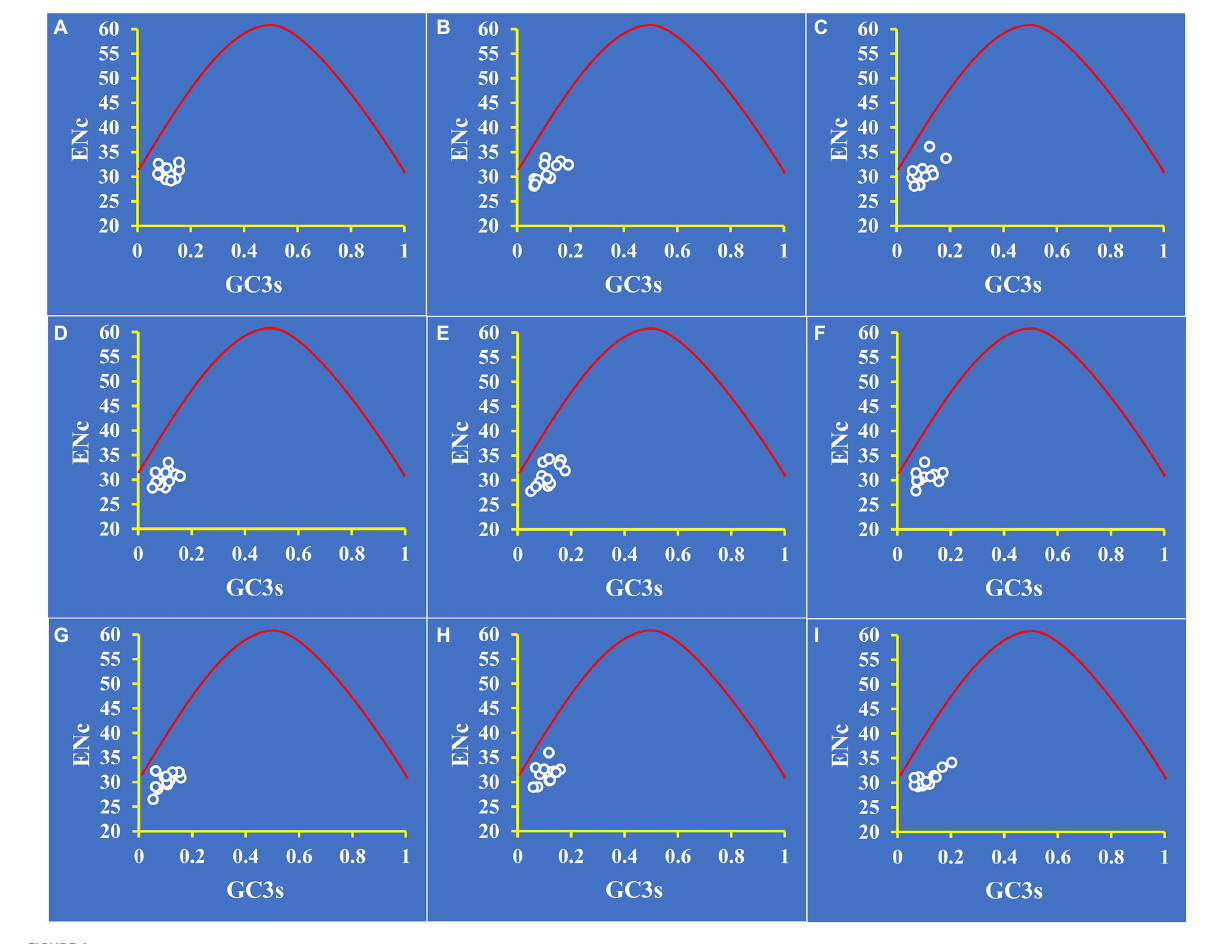
FIGURE 4 ENC-GC3 plot analysis of 12 core PCGs in nine Amanita species. The red solid line represents the expected curve when codon usage bias is affected only by mutation pressure. (A) , A. basii ; (B) , A. bisporigera ; (C) , A. brunnescens ; (D) , A. muscaria ; (E) , A. phalloides ; (F) , A. pseudoporphyria ; (G) , A. sinensis ; (H) , A. inopinata ; and (I) , A. thiersii